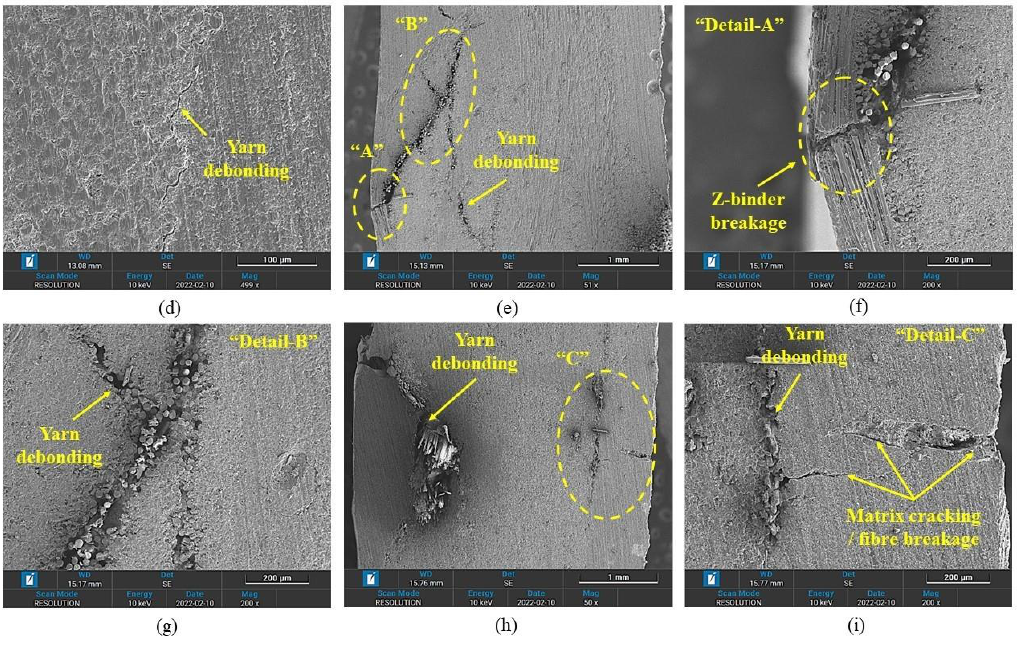
Figure 10. Comparison of intralaminar/interlaminar failure mechanisms in off-axis (30º, 45º and 90º) specimens. ( a – d ) TP-3D-FRC and ( e – i ) TS-3D-FRC.